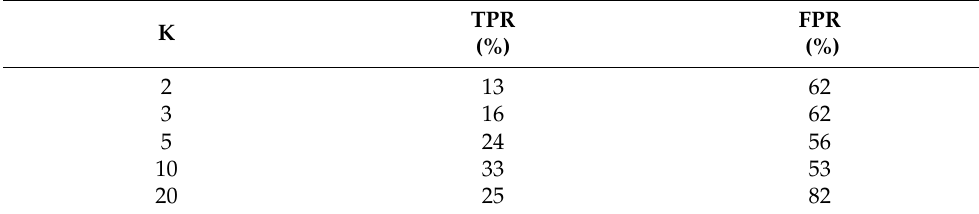
Table 9. Evaluation with metrics of the K-nearest neighbors method.